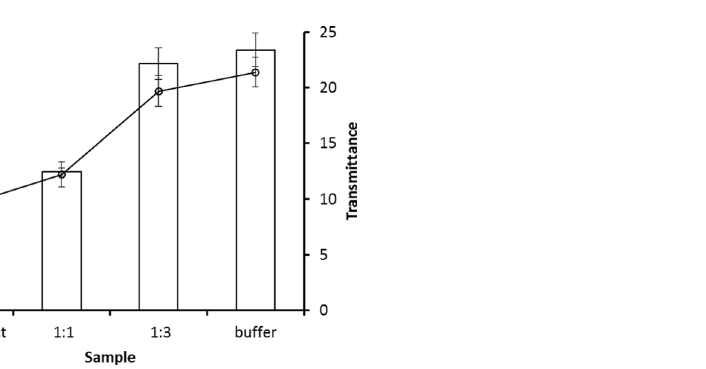
Fig 6. The effect of dilution of S . feltiae extracts with tris buffer on crystal diameter (bars) and optical transmittance (arbitrary units) (line) after annealing for 30 min at – 8°C. Error bars represent ± standard deviations, N = 10 for crystal diameter and 4 for optical transmittance.